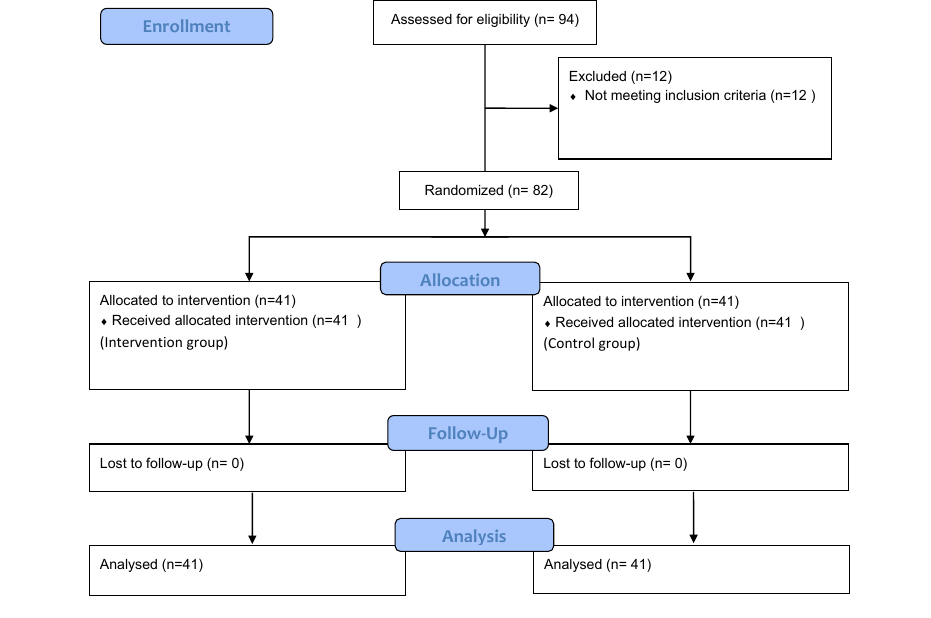
Figure 1. The CONSORT Flow Diagram.